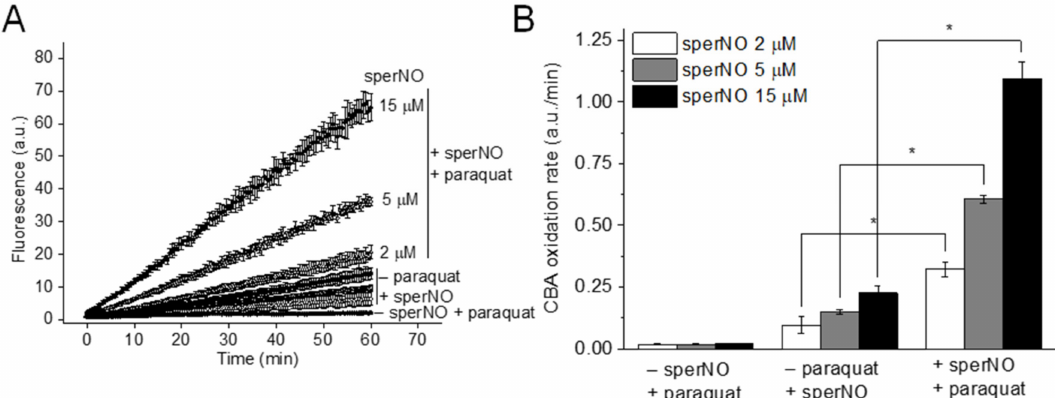
Figure 2. Formation of peroxynitrite by paraquat and NO • donor in cells. Briefly, suspensions of RAW 264.7 cells were transferred to 96-well plates (1.2 × 10 7 cells/mL). CBA (10 µ M), paraquat (10 µ M), and sperNO (2, 5 or 15 µ M) were individually added to selected wells, in this order. ( A ). COH fluorescence as a function of time. The measurements were initiated immediately after sperNO was introduced, and the fluorescence was registered every minute for one hour. The data represent the mean ± SD ( n = 4). ( B ). Increase in the rate of COH fluorescence. This parameter was determined by linear regression of the fluorescence data presented in panel A within the first 10 min of each run. The data represent the mean of four independent experiments ± S.D. and are statistically significant at the 95% confidence interval relative to control cells * ( p < 0.05, Paired Student’s t-test). The assays were performed in PBS, DTPA (100 µ M), at pH 7.4 and 37 ◦ C, and the fluorescence acquisition parameters were λ ex = 332 nm, λ em = 456 nm, and ex and em slit width = 9 and 15 nm,